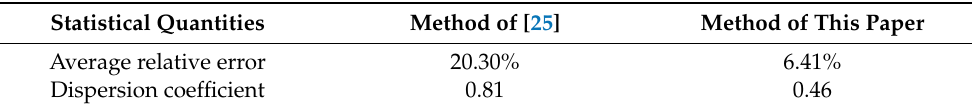
Figure 10. Relative errors of the third moment calculated by the method of this paper and the method of Yan, W 2003 [25]. Table 5. Average relative errors and dispersion coefficient of the third moment.